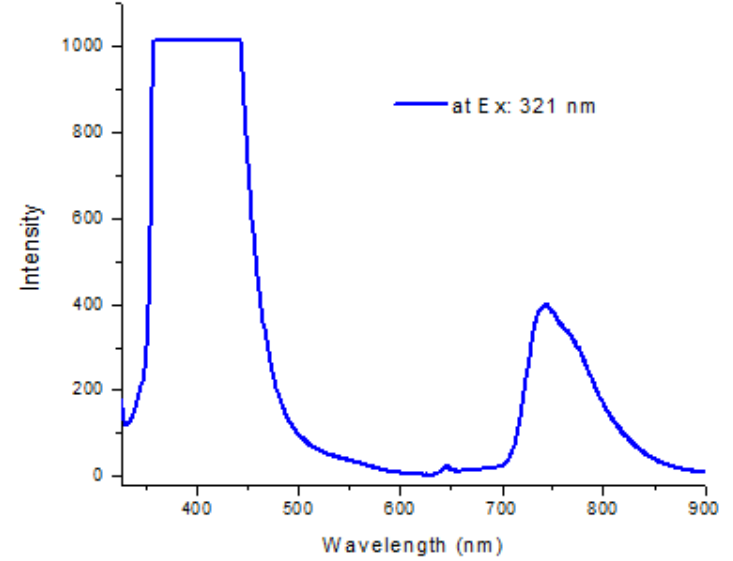
Figure S19: Emission spectrum of Schiff base polymer P m HOBND